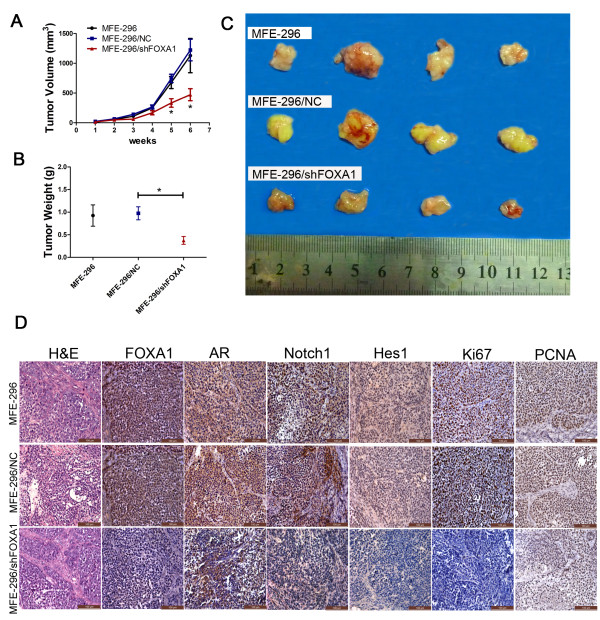
Tumorigenicity assay in nude mice. A: The growth rates of tumors formed from untransfected MFE-296 cells (MFE-296) and MFE-296 cells transfected with NC (MFE-296/NC) or shFOXA1 (MFE-296/shFOXA1). After injection, tumor volumes were calculated every seven days. B and C: Six weeks after injection of MFE-296, MFE-296-NC, and MFE-296-shFOXA1 cells, tumors were removed, and the tumor weights and volumes were determined. Arithmetic means and SD are shown. D: Staining with hematoxylin and eosin (H&E) or immunohistochemical staining for FOXA1, AR, Notch1, Hes1, Ki67, and PCNA in mouse tumor tissues (immunohistochemical staining, 200×). *p < 0.05 compared with the NC group.